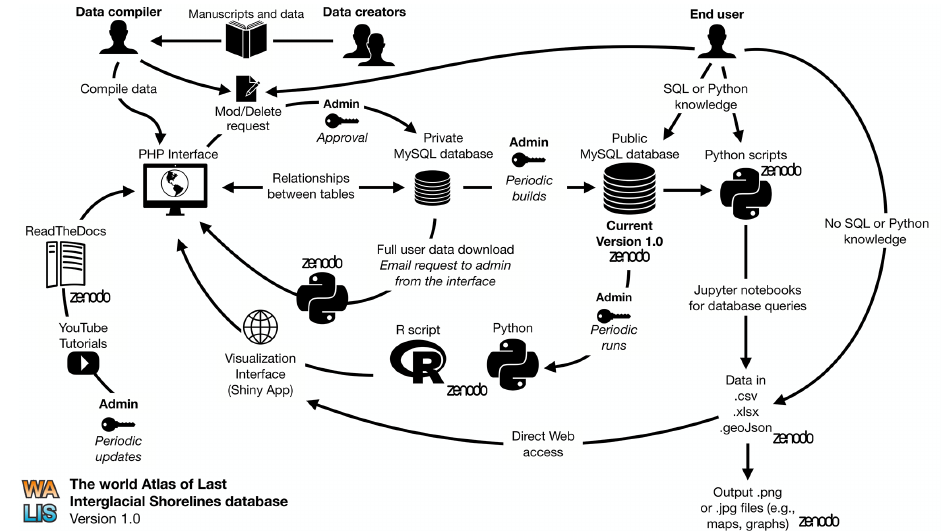
Figure 1. Overview of the WALIS platform, which includes the private and public instances of the database, the PHP data interface, and scripts in R and Python to query and visualize the data. The “Zenodo” logo indicates that the scripts/data are available in Zenodo (see Table 1 for links).